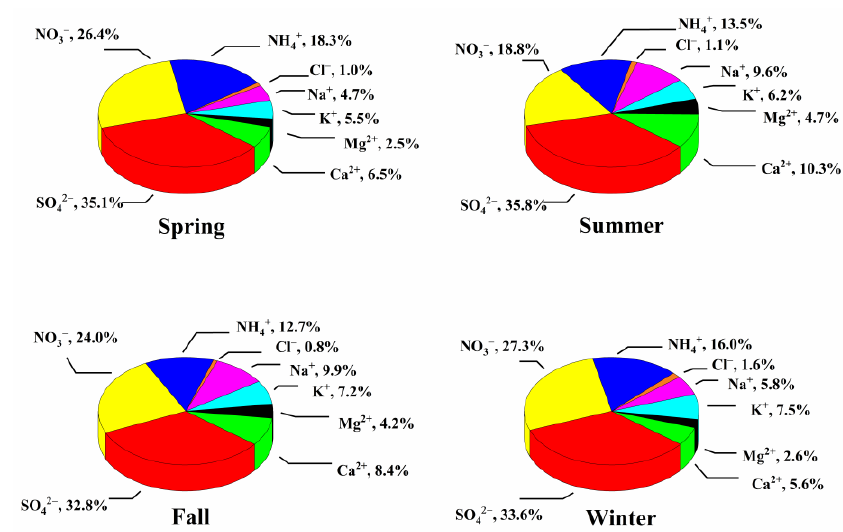
Figure 3. Relative percentages of each water-soluble ion to all water-soluble ions tested.